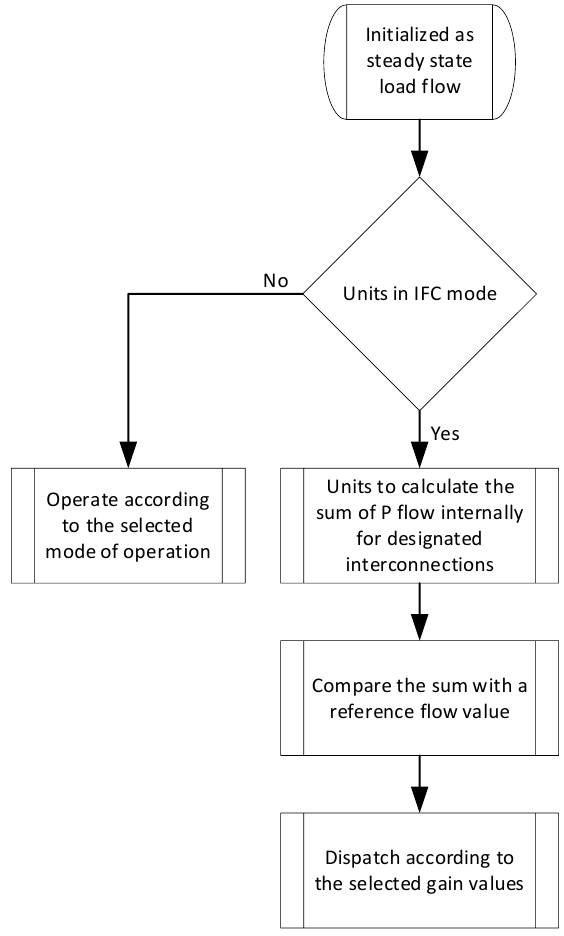
Figure 5. Proposed methodology.